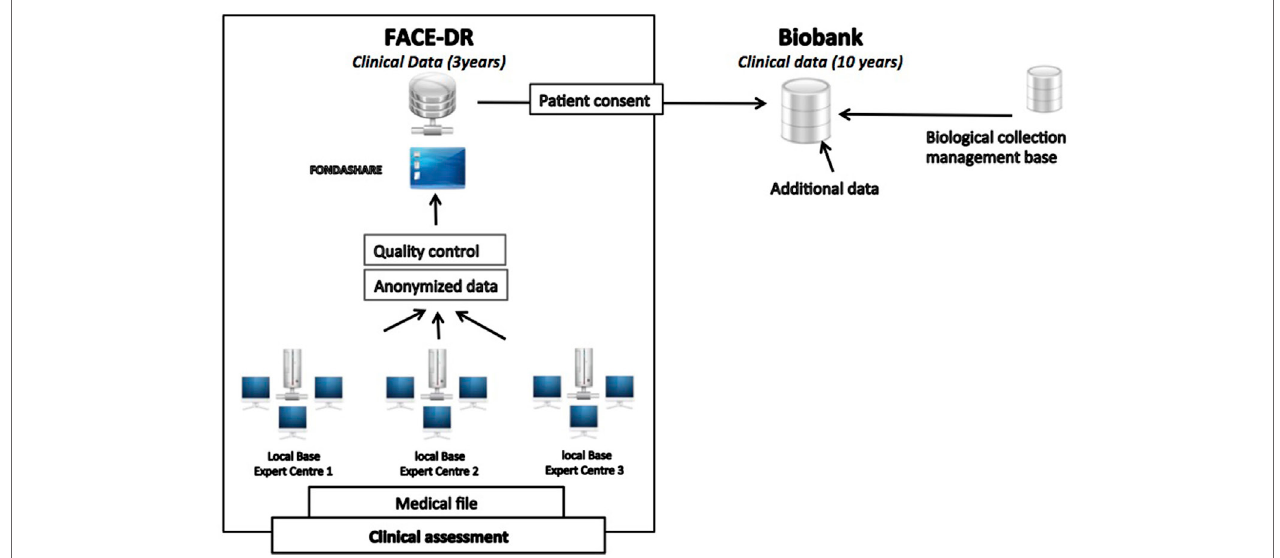
FigurE 1 | Treatment-Resistant Depression Network organization throughout the French